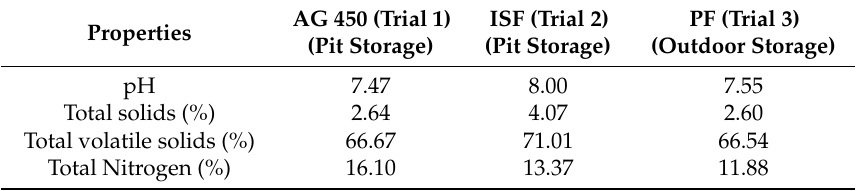
Table 1. Properties of swine manure (pit- or outdoor stored) used in the